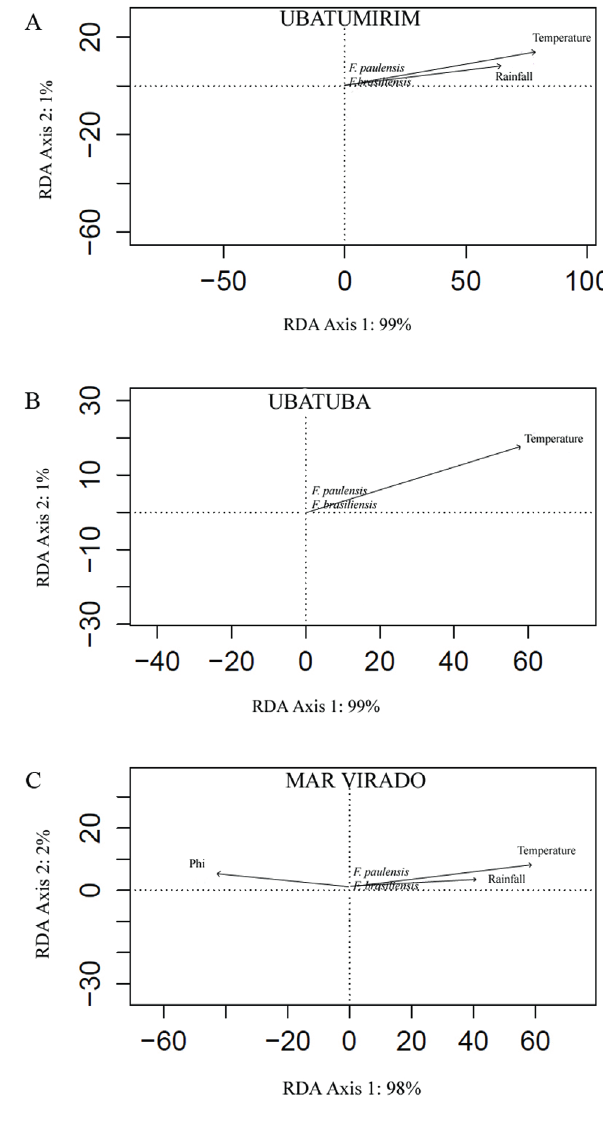
Figure 7. Redundancy analysis showing the relative abundance of Farfantepenaeus brasiliensis and F. paulensis with environmental factors sampled from January 1998 to December 1999 in the bays of Ubatumirim (A), Ubatuba (B) and Mar Virado